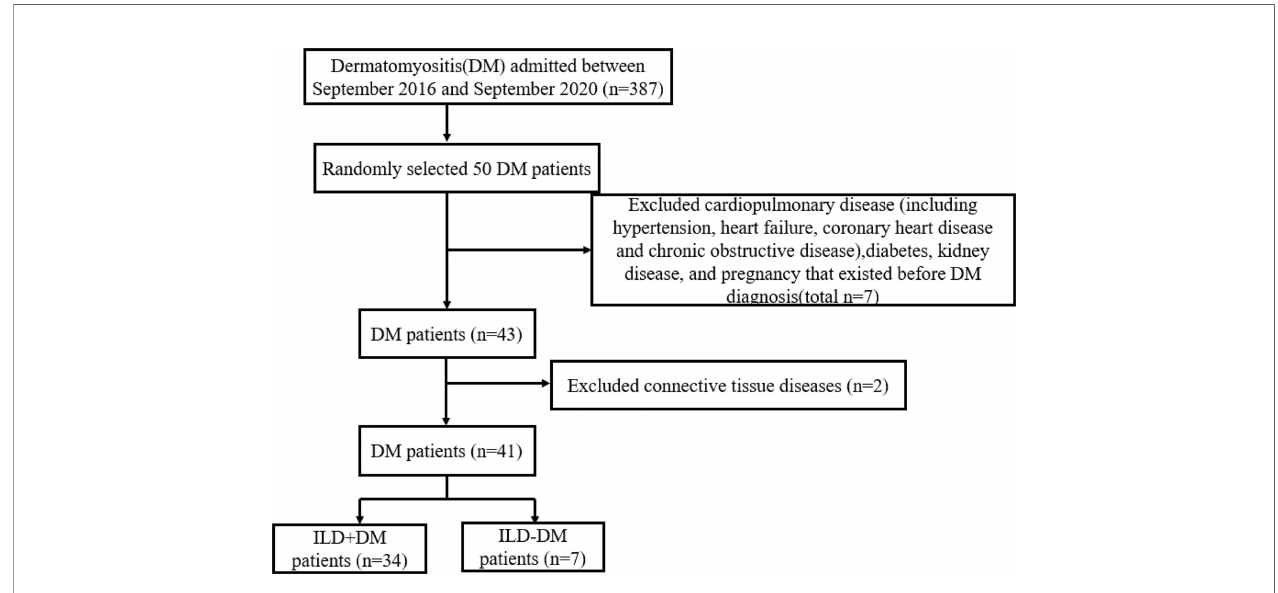
FIGURE 1 | Selection fl